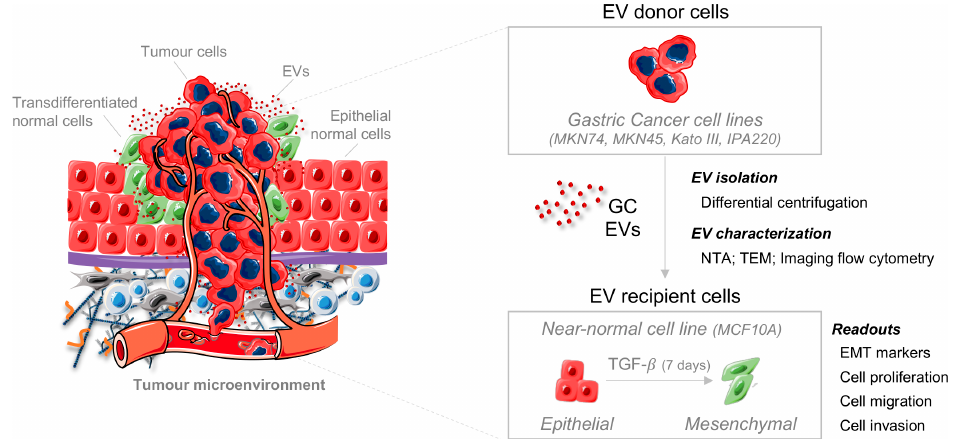
Figure 1. Scheme illustrating the experimental design of the study. Four distinct gastric cancer (GC) cell lines (MKN74, MKN45, Kato III, and IPA220) were used as donor cells of extracellular vesicles (EVs), which were isolated by differential centrifugation and characterized by transmission electron microscopy (TEM), nanoparticle tracking analysis (NTA), and imaging flow cytometry. Epithelial (red) and mesenchymal (green) cells were used as recipients of GC-EVs and submitted to distinct functional assays.